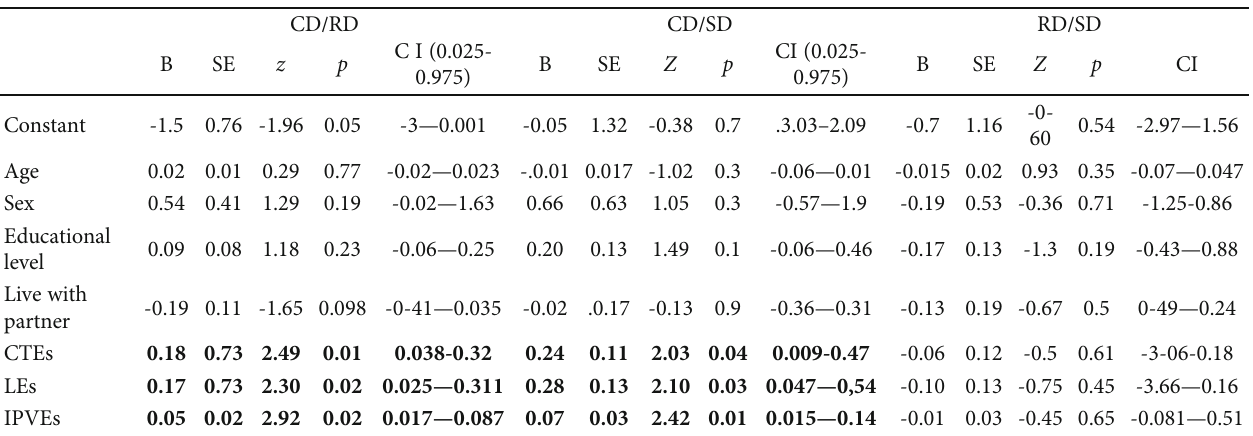
Table 4: Multinomial regression model between complex depression (CD), recurrent depression (RD), single depression (SD) classes and on sociodemographic and adverse biographical background (CTEs, LEs, IPVEs), in 297 Chilean PHC depression